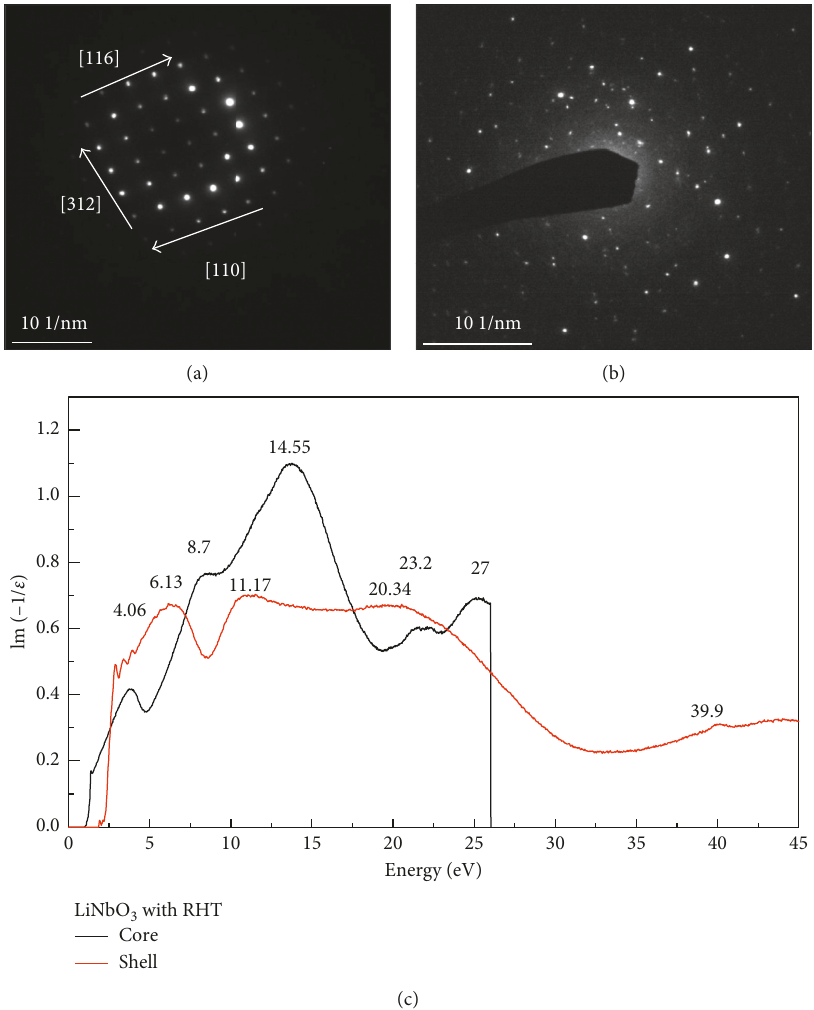
Figure 3: (a) Selected area diffraction with no RHT; (b) selected area diffraction after the RHT; (c) EELS spectrum. Black plot related to the core, and red plot related to the